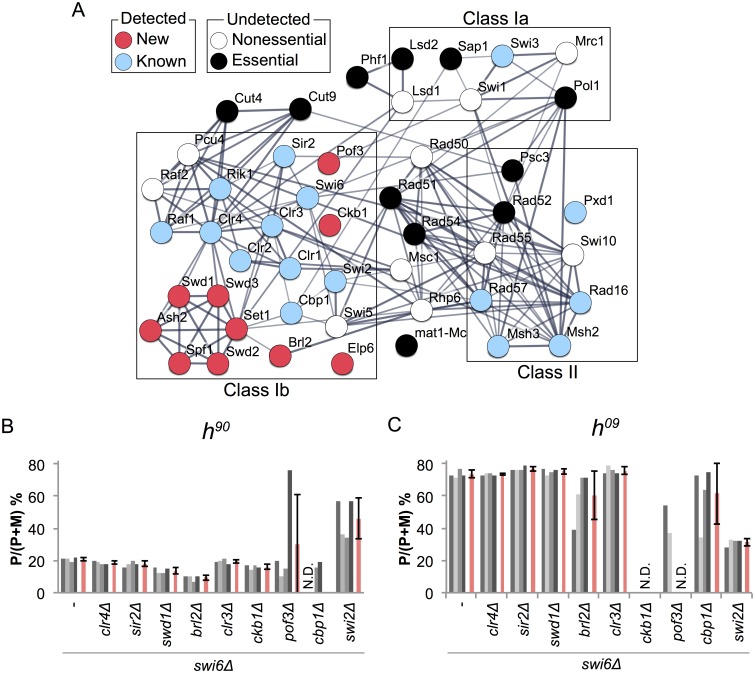
Protein interaction network and genetic interactions.(A) An interaction network of newly identified and previously known mating-type switching factors (Table 1) was obtained from the STRING database (v10.0). The proteins are represented by nodes. Red and blue nodes show factors detected in this screen. White and black nodes show known mating-type switching factors that were not detected in this screen, either because the gene deletions were not in the library, or due to the set thresholds or human error. The line thickness represents the strength of the association (confidence > 0.6). It has been suggested that the presence of the DSB at mat1 is lethal in deletion mutants of rad51, rad52 and rad54 [36, 38]). (B, C) Genetic interactions between swi6 and the identified Class Ib genes. mat1 content was quantified for the indicated double mutants with the h90 (B) or h09 (C) mating-type region. The relative P band intensities (P/(P+M)) were calculated from gels shown in S6 Fig. Red bars represent means ± SD.